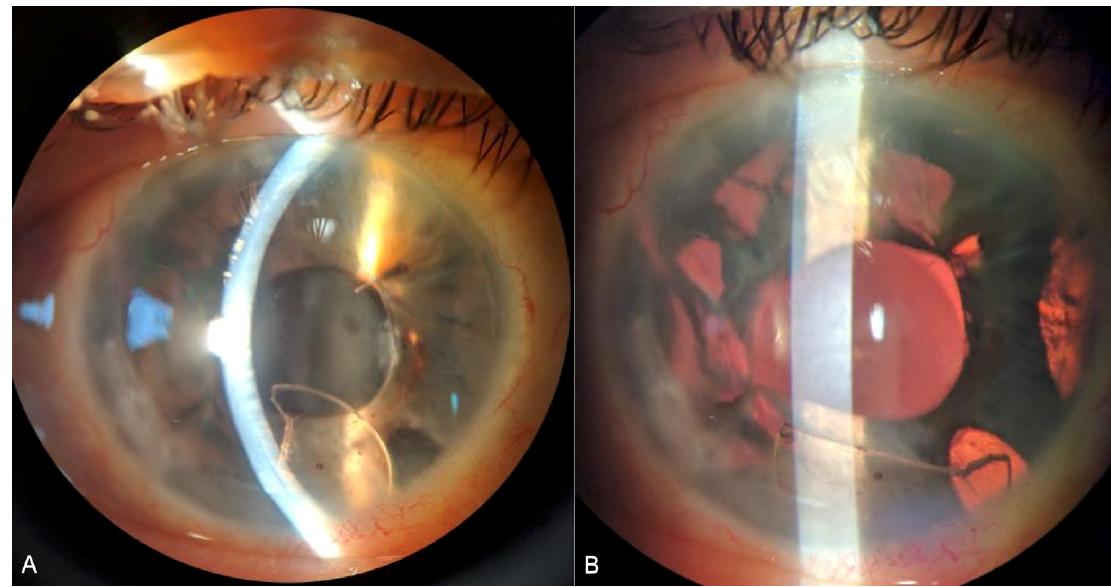
Figure 1: A) Anterior segment photograph of large optic fragment (arrow) in the anterior chamber with mild corneal edema. B) Same image with retroillumination highlighting the iris transillumination